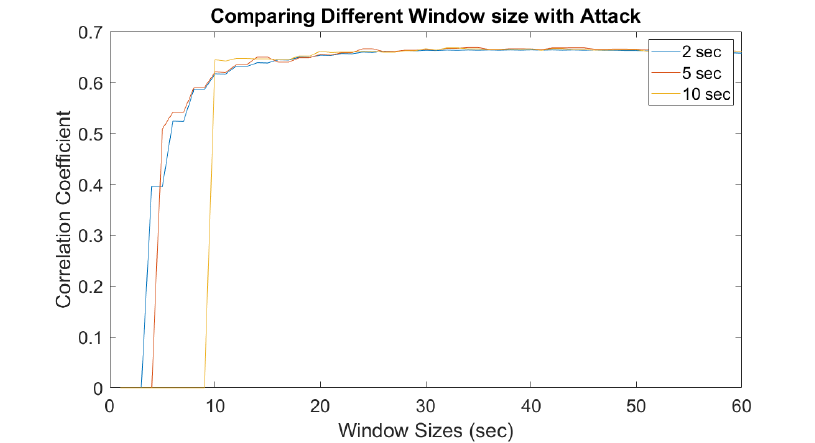
Figure 11. Window sizes for power and attacked